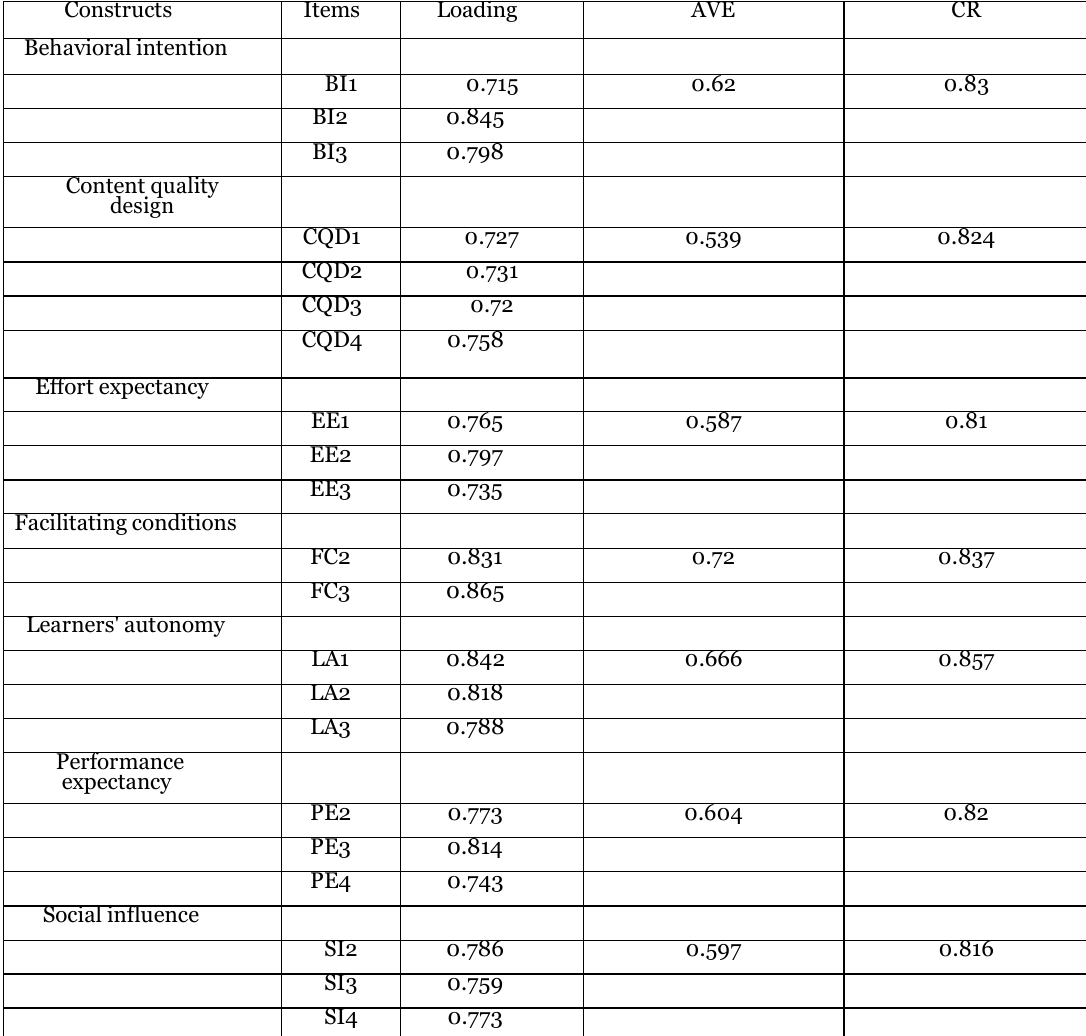
Results for the Measurement